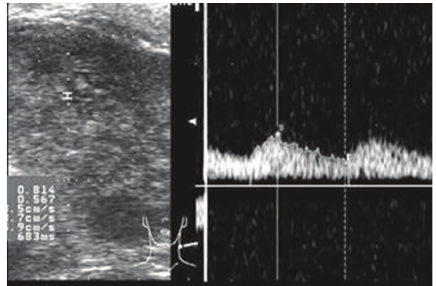
Figure 8: On USG neck, hypoechoic mass is seen on the left parapharyngeal space showing mild vascularity on Doppler study.